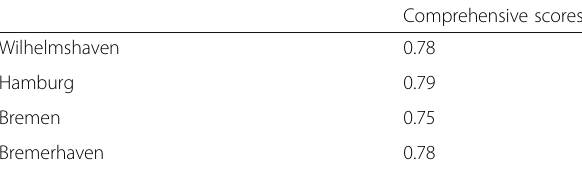
Table 17 Weights of level indicators and secondary indicators by AHP. (Source: Authors)